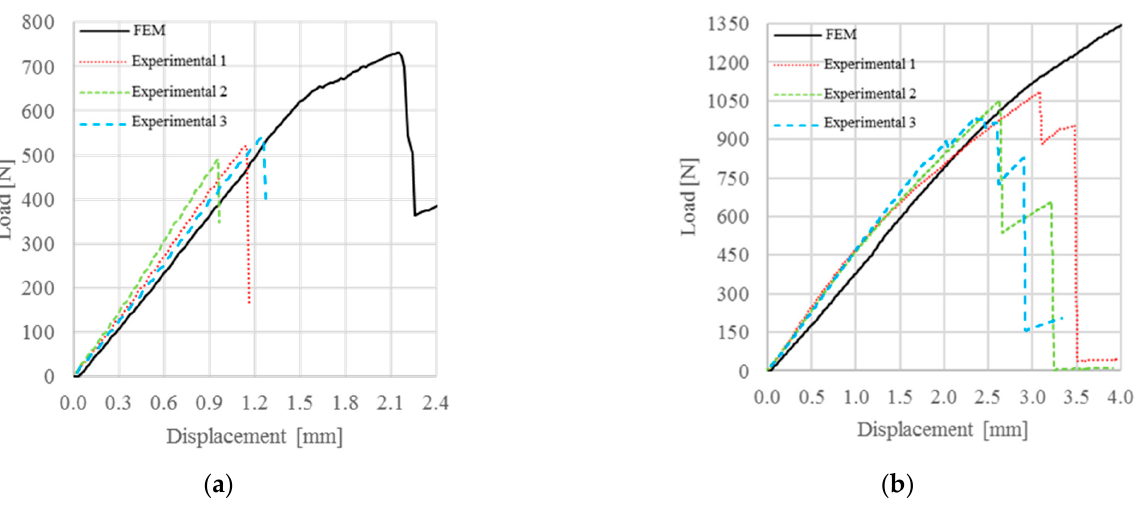
Figure 7. Comparison between experimental and numerical P- δ curve obtained with the exponential law for: ( a ) untreated specimens; ( b ) 13% treated specimens.